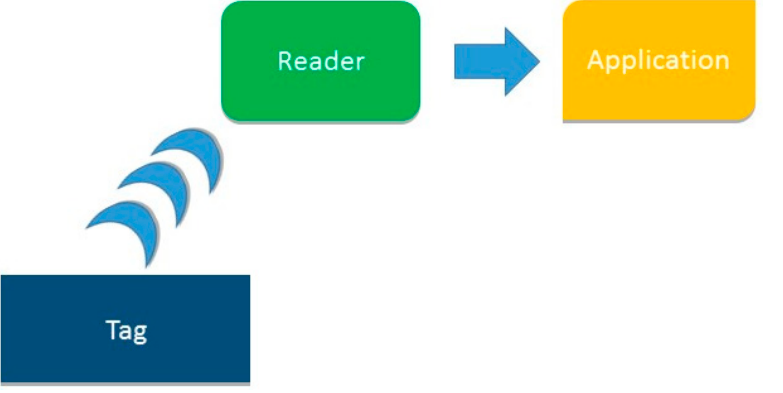
Figure 1. The functioning of RFID technology.